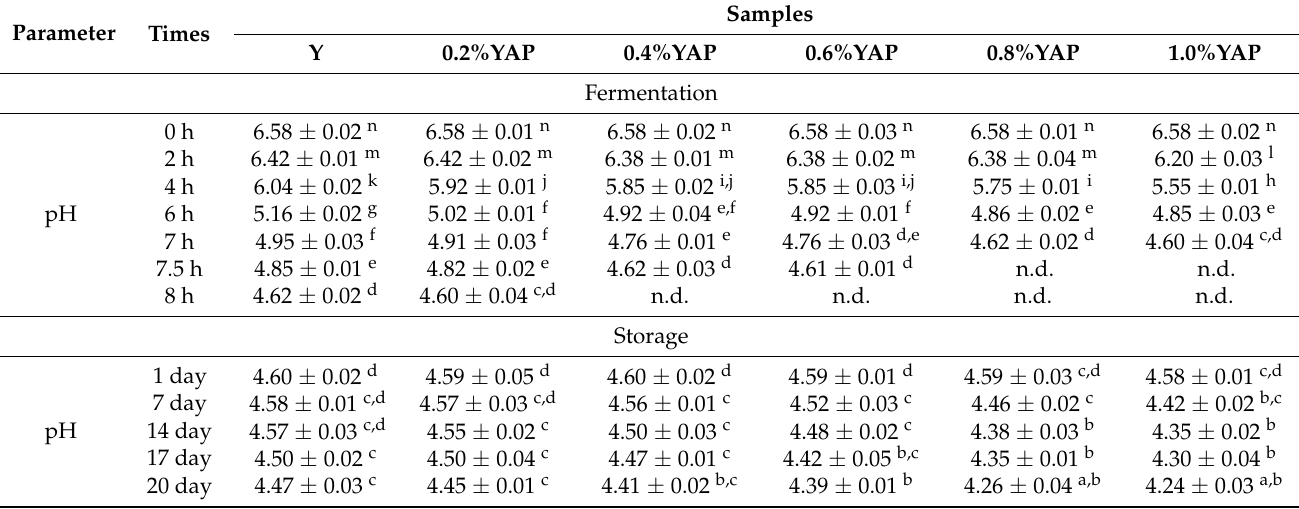
Table 6. pH value evolution of yogurt with apple pomace powder during fermentation and